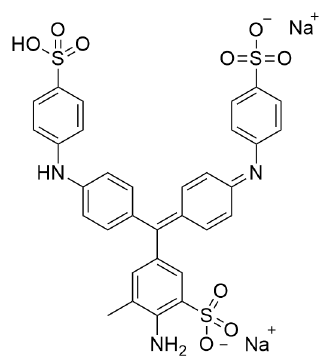
Figure 1. The chemical structure of aniline blue.